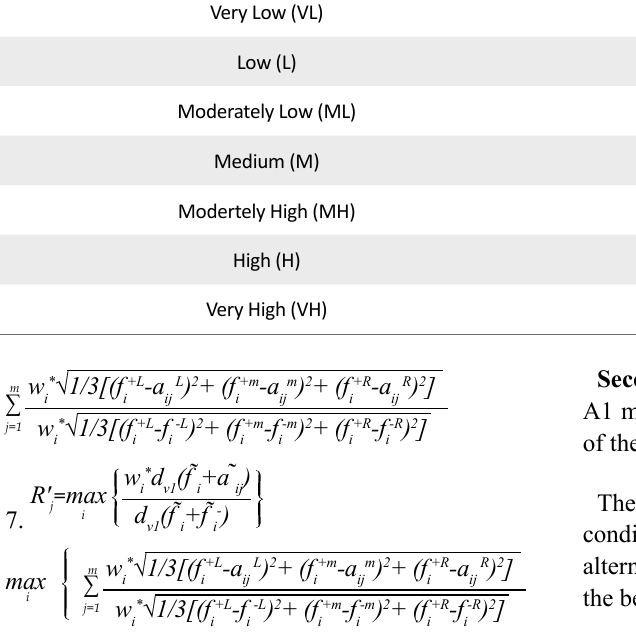
Table 1. Converting the ratios of options to triangular fuzzy numbers [31] Expressive